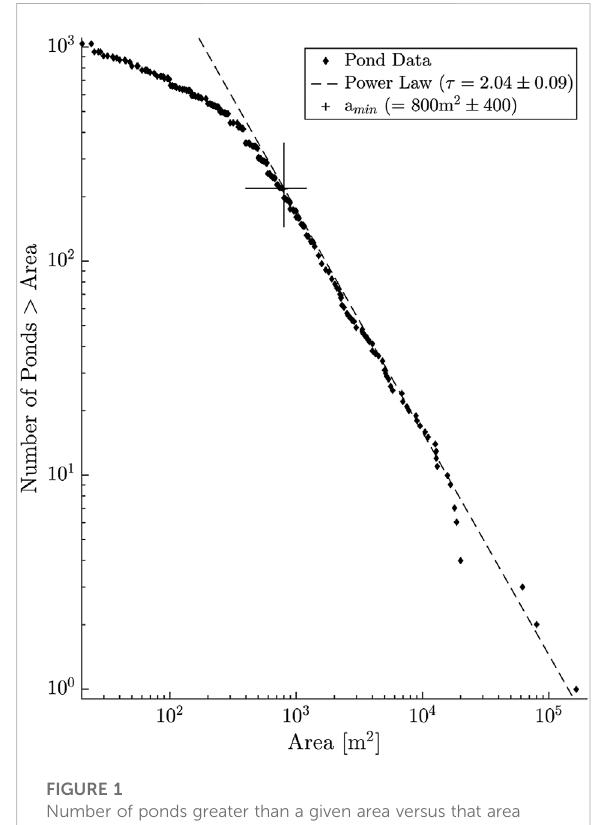
FIGURE 1 Number of ponds greater than a given area versus that area for the CEH dataset, fi t by a power law. Diamonds correspond to empirical distribution; dashed line corresponds to a power-law fi t with an exponent of 2.04 and a minimum area of 800 m 2 . Power-law parameters and uncertainties calculated according to Clauset et al. (2009). Note that the slope shown is for the cumulative distribution, which being an integral of the probability distribution has a slope 1